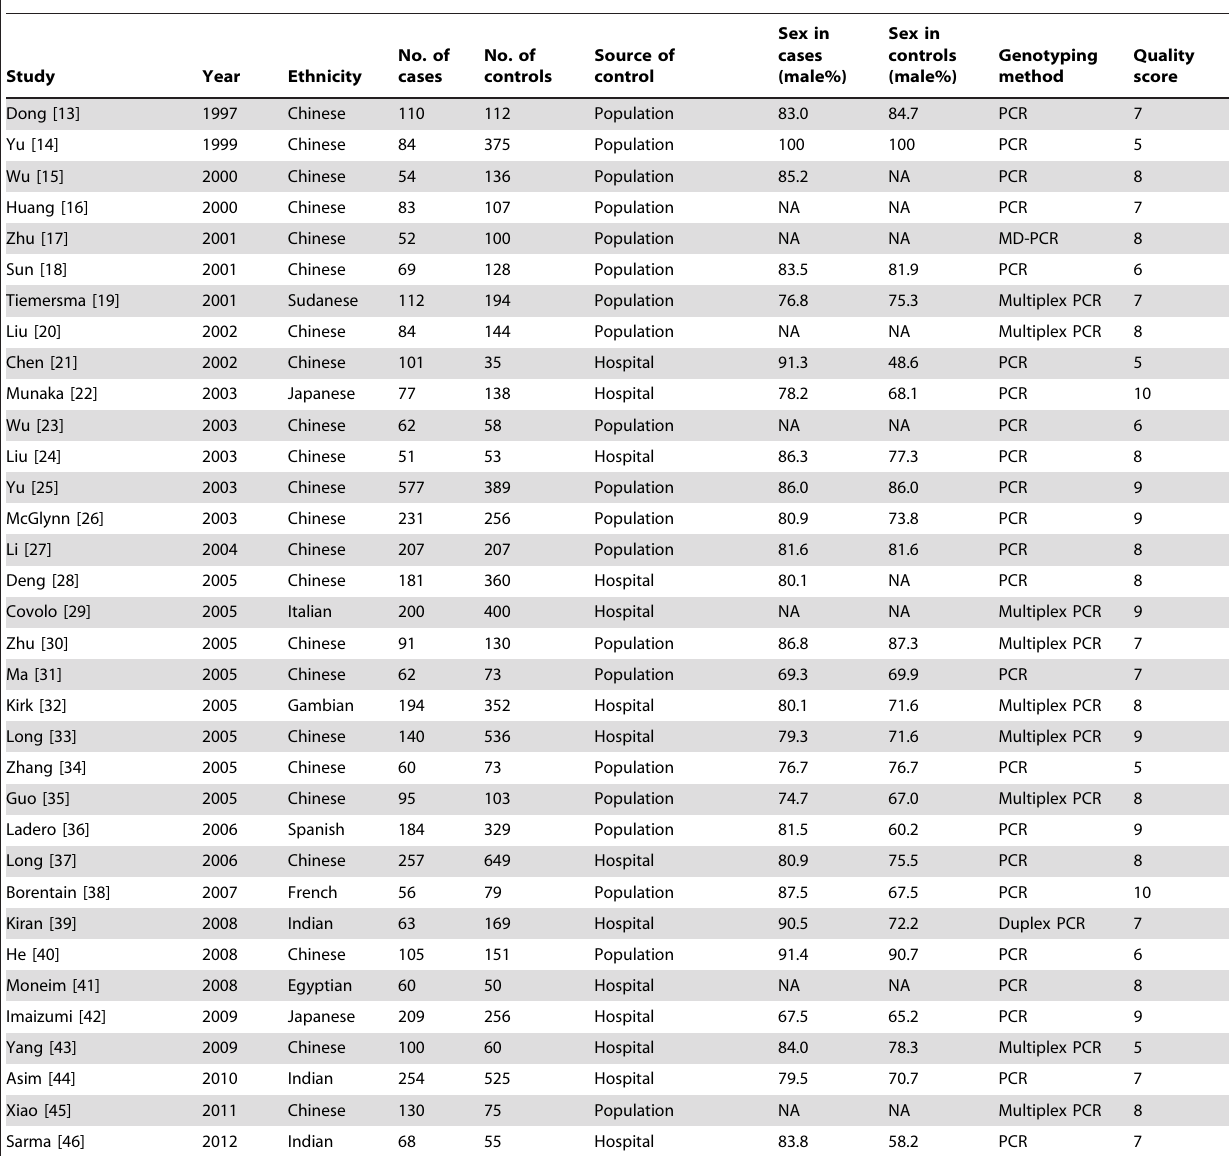
Table 1. Characteristics of the studies included in the